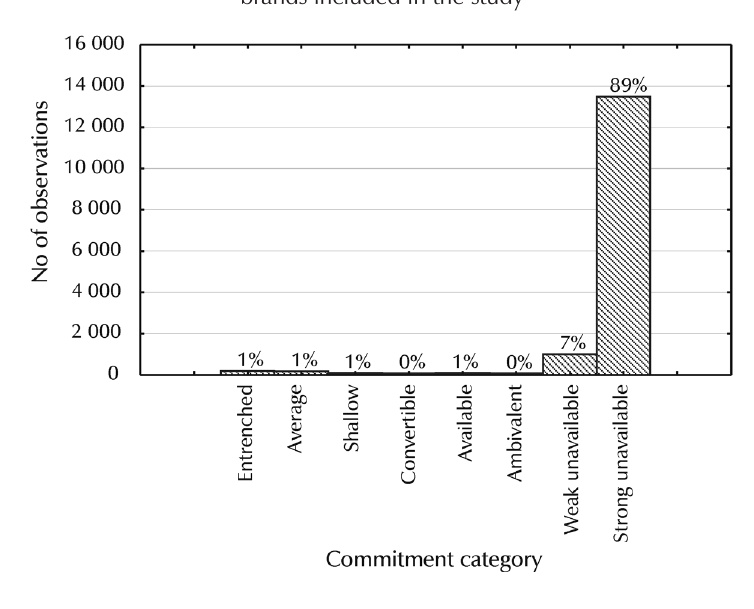
Commitment categories of the conversion model for the motor vehicle brands included in the study